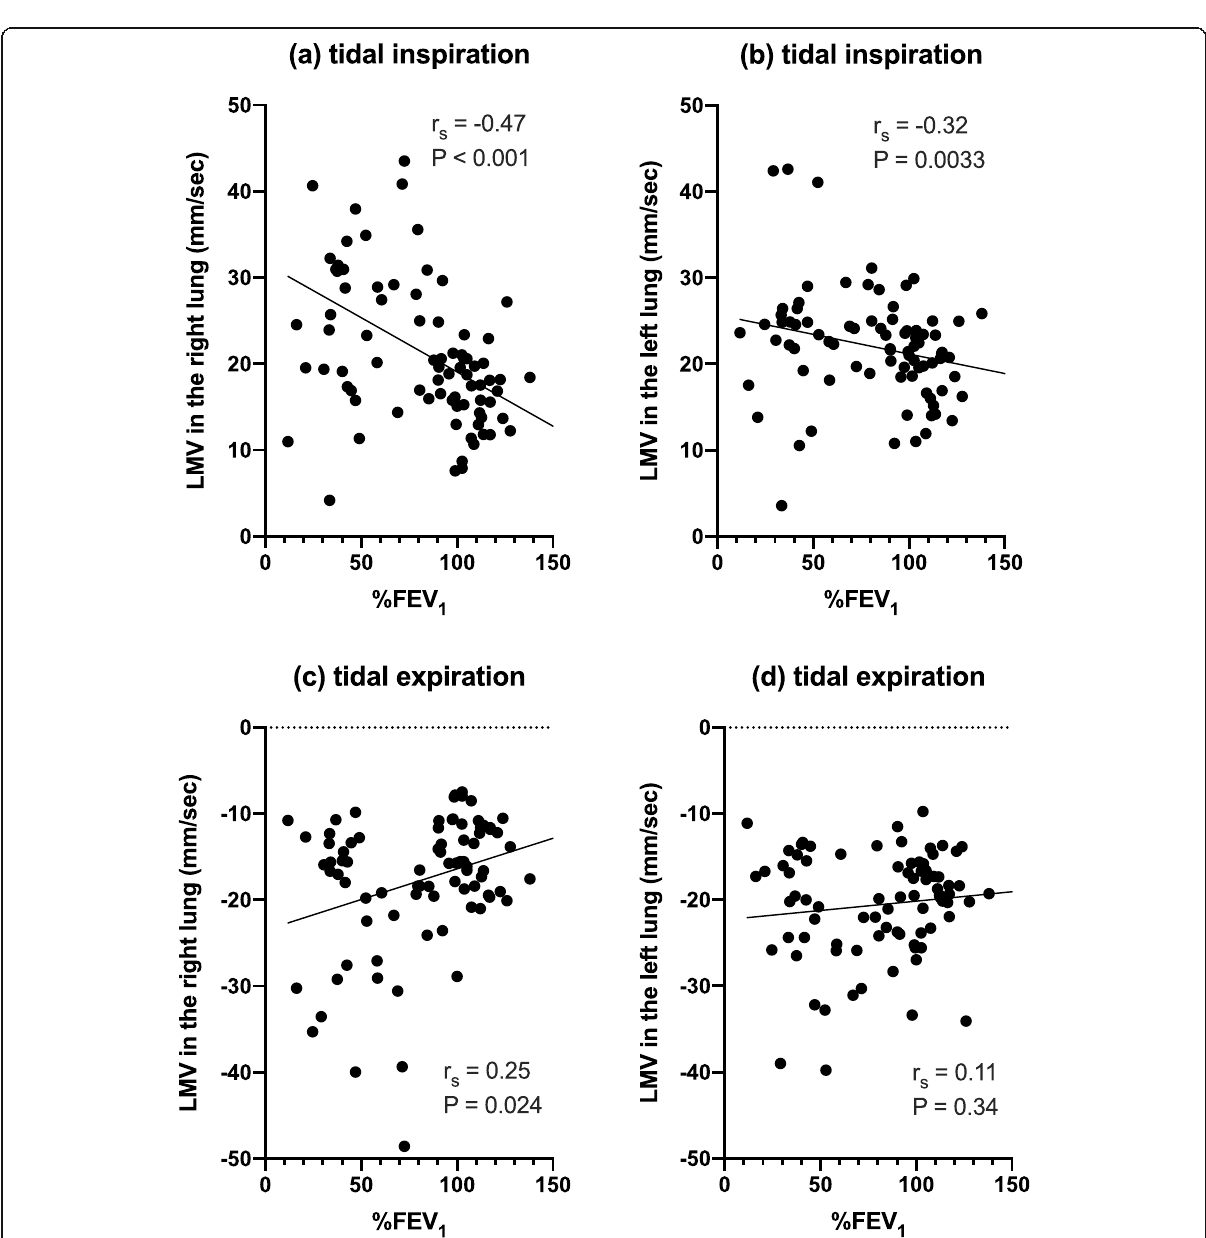
Fig. 5 Scatter plots of %FEV 1 and bilateral LMV in tidal respiratory phase with approximate line. LMV in the tidal inspiration phase versus %FEV 1 in the right lung ( a ) and in the left lung ( b ). LMV in the tidal expiration phase versus %FEV 1 in the right lung ( c ) and in the left lung ( d ). In each phase, the statistically significant correlation between %FEV 1 and LMV in tidal inspiration in both lungs as well as those between %FEV 1 and LMV in tidal expiration in the right lung was indicated by the Spearman rank correlation coefficient. COPD Chronic obstructive pulmonary disease, %FEV 1 Percent predicted forced expiratory volume in one second, LMV Lung motion velocity, r s Spearman ’ s rank correlation